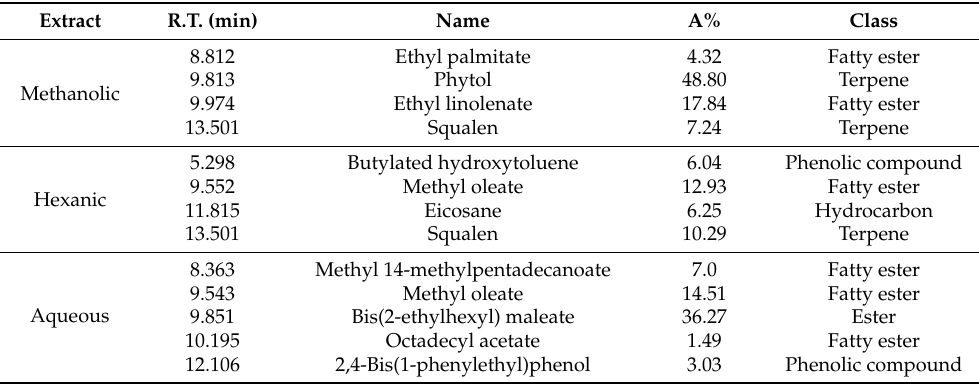
Table 3. Metabolites of P. alliacea L. leaves identified by